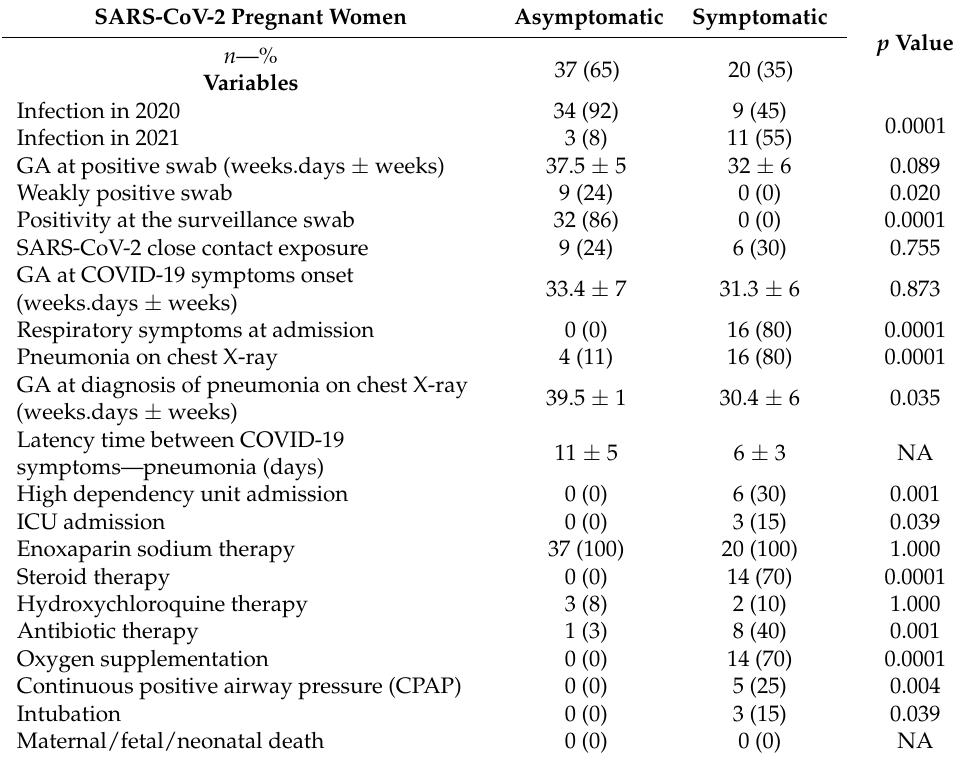
Table 3. SARS-CoV-2 infection characteristics comparing symptomatic vs. asymptomatic women at the hospital admission [Mean; standard deviation—SD; n ;